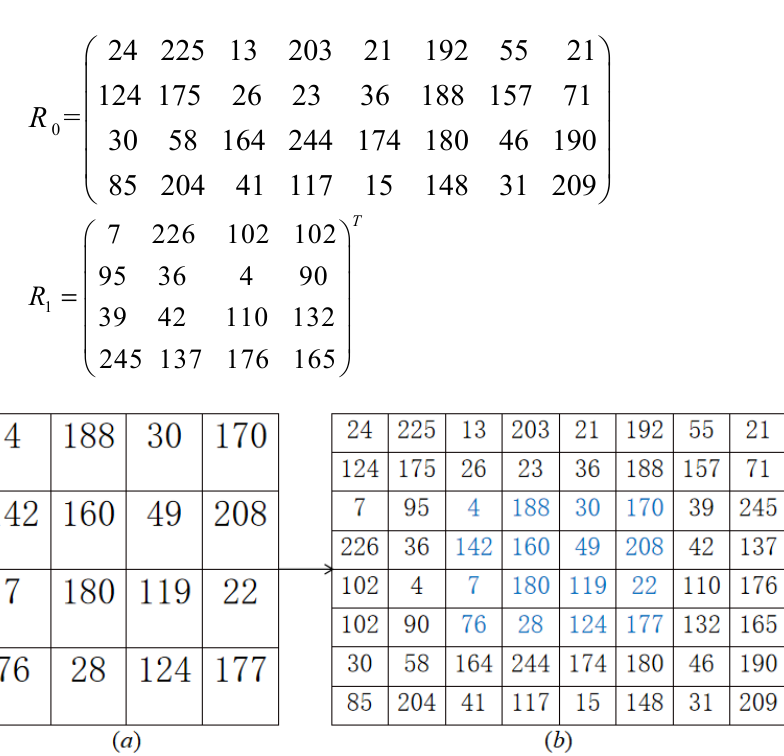
Figure 3. Image dilation. ( a ) The primitive image matrix; ( b ) The extended image matrix.